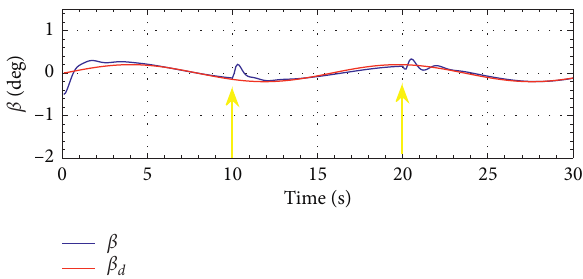
Figure 16: Tracking result of the sideslip angle β .